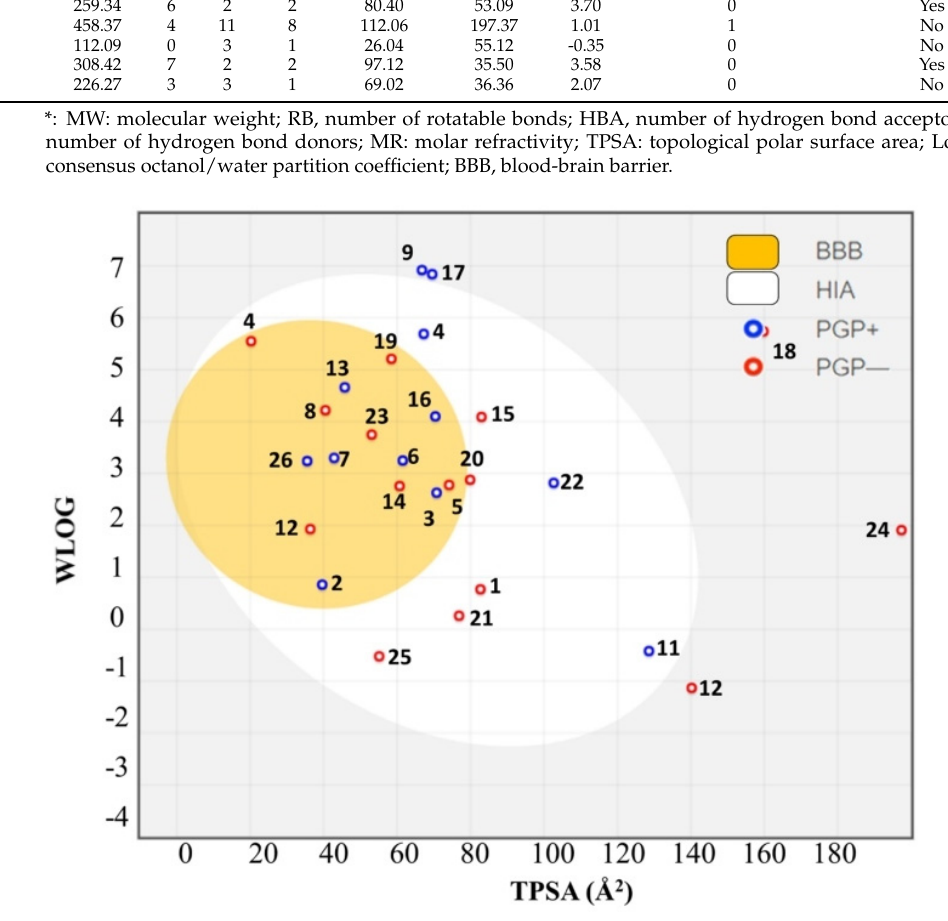
Figure 10. Predictive human intestinal absorption (HIA) model and blood-brain barrier permeation (BBB) method (boiled-egg plot) of the 27 compounds. Resveratrol ( 1 ), Magnolol ( 2 ), PM263 ( 3 ), 8a ( 4 ), (E)-Hydroxystyryl Aralkyl Sulfones ( 5 ), N-Docosahexaenoyl dopamine ( 6 ), Ginkgetin ( 7 ), Biochanin A ( 8 ), EGCG ( 9 ), DHC12 ( 10 ), CT51 ( 11 ), Coumarin 24 ( 12 ), M30 ( 13 ), HLA20 ( 14 ), 2-heptyl-3-hydroxyquinolin-4(1H)-one ( 15 ), D-607 ( 16 ), D-520 ( 17 ), D-653 ( 18 ), 1b ( 19 ), 1,2-HOPY ( 20 ), 2-Pyridones derivatives ( 21 ), T-006 ( 22 ), Celastrol ( 23 ), Ferruginol ( 24 ), Ginkgolide K ( 25 ), MT-20R ( 26 ) and APH-4 ( 27